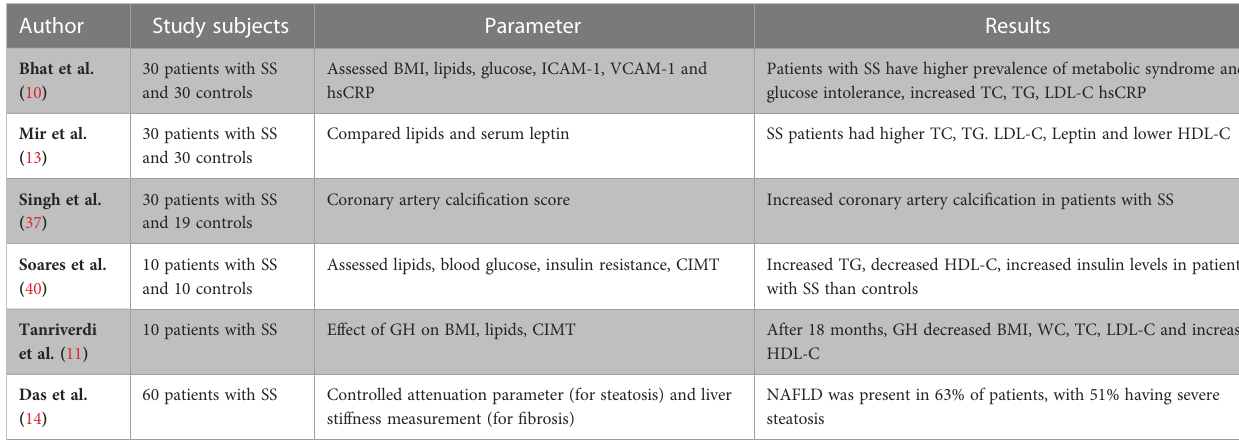
TABLE 1 Summary of metabolic abnormalities in patients with